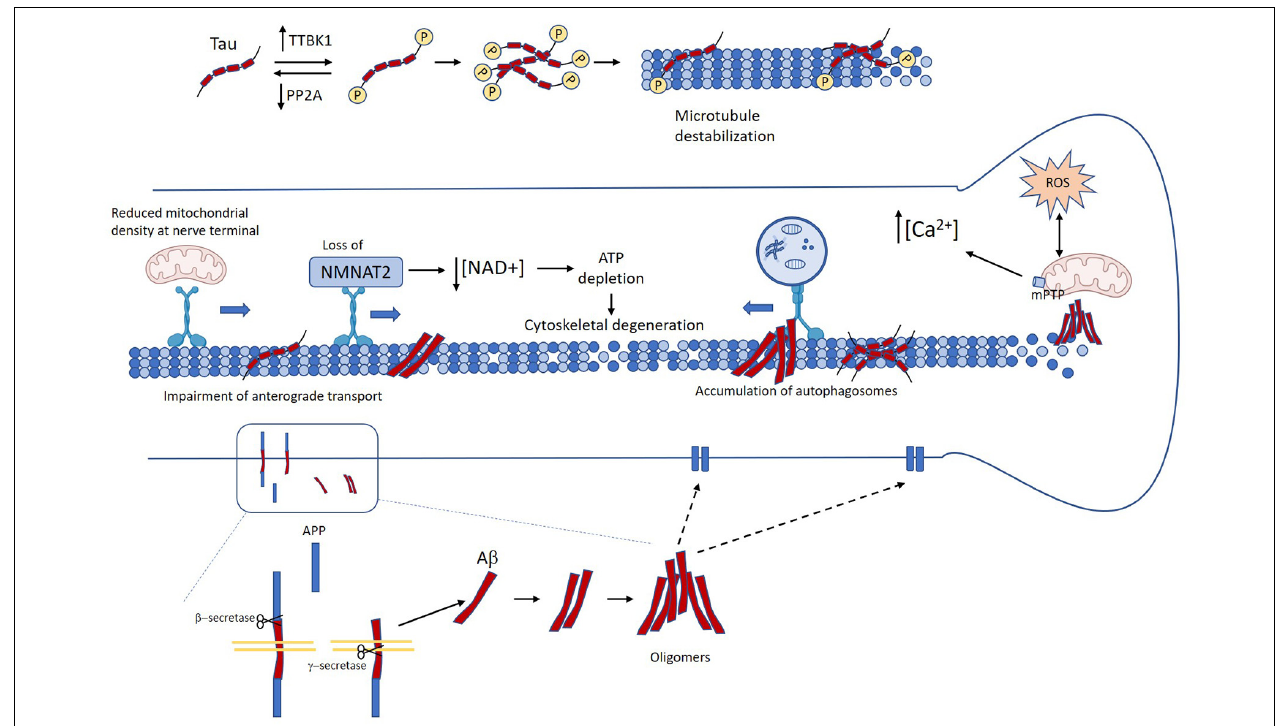
FIGURE 2 | Mechanisms linking Tau and amyloid- β (A β ) in Alzheimer’s disease (AD) to axon degeneration. Unbalance between kinases and phosphatases leads to the accumulation of abnormally phosphorylated tau, which in turn induces detachment form microtubules and microtubule destabilization (Köpke et al., 1993). Several age-related factors contribute to the accumulation of A β oligomers. Accumulation of pathological tau and A β promote axonal transport impairment (Calkins and Reddy, 2011; Tang et al., 2012; Wang et al., 2015; Sadleir et al., 2016; Zhang et al., 2018). This in turn causes loss of axonal NMAT2, decreased mitochondrial density at the nerve terminal, and autophagy flux impairment (Gilley and Coleman, 2010; Ljungberg et al., 2011; Ali et al., 2016). Neuron loss and neurofibrillary tangle (NFT) and A β oligomers also promote mitochondrial dysfunction, oxidative stress, and calcium dyshomeostasis (Stamer et al., 2002; Chee et al., 2005; Cieri et al., 2018; Mata, 2018; Albensi, 2019). All these events drive the failure of critical mechanisms for axonal functioning and maintenance that lead to loss of axonal homeostasis, and ultimately axon